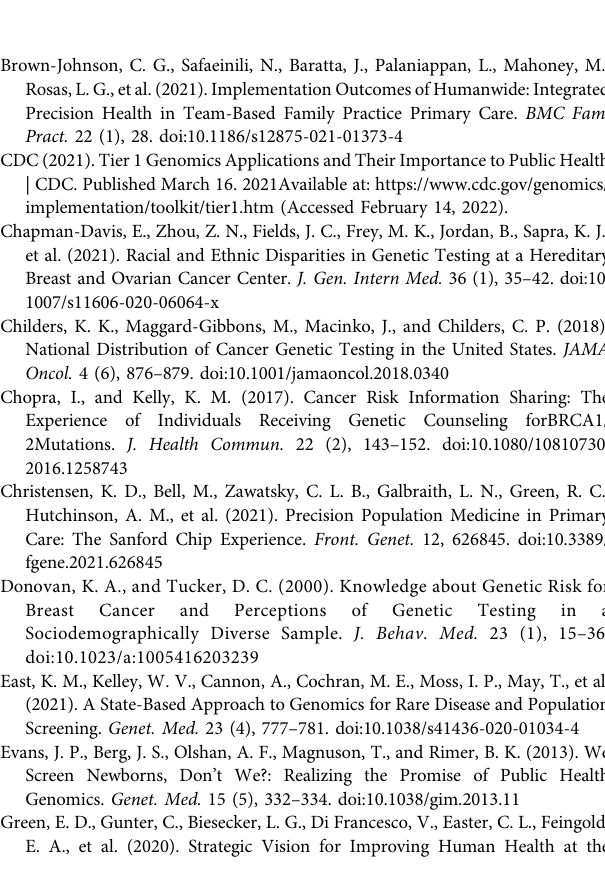
Supplementary Figure S1 | Survey fl ow and primary measures of